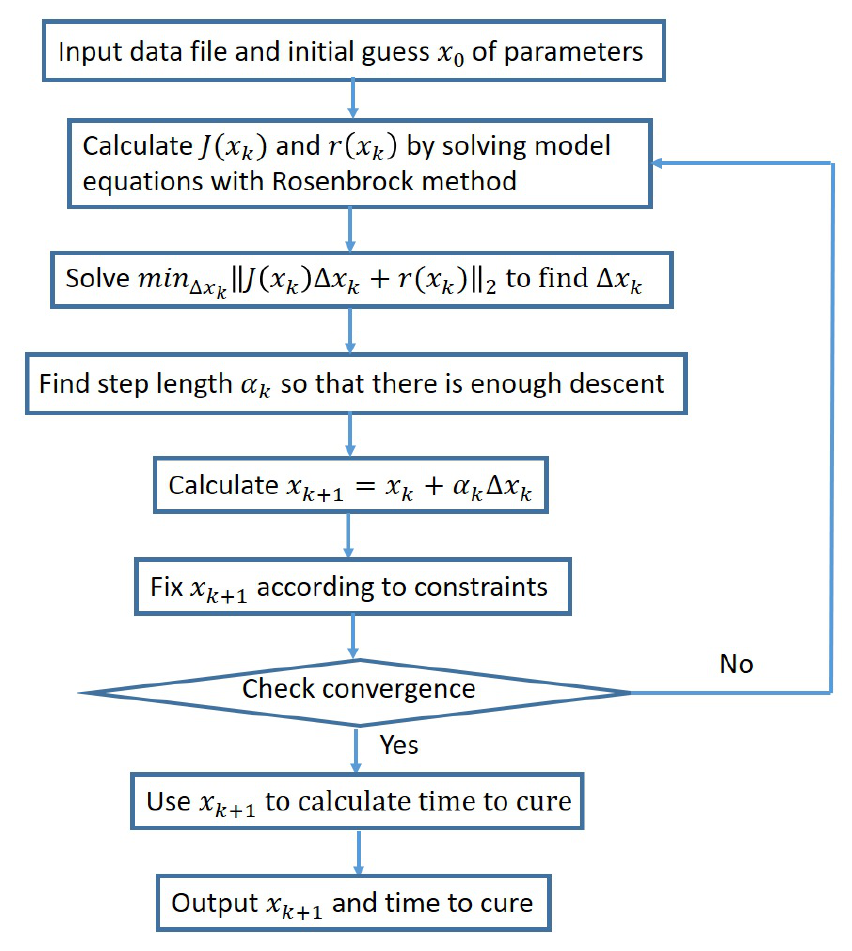
Figure 1. A flowchart of our constrained damped Gauss–Newton